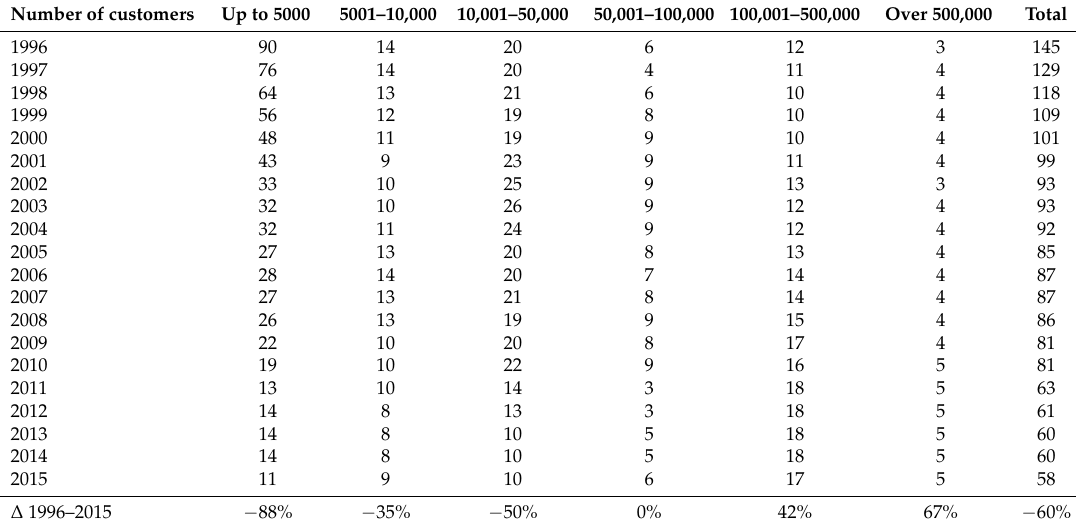
Table 2. Number of insurers by portfolio size (number of